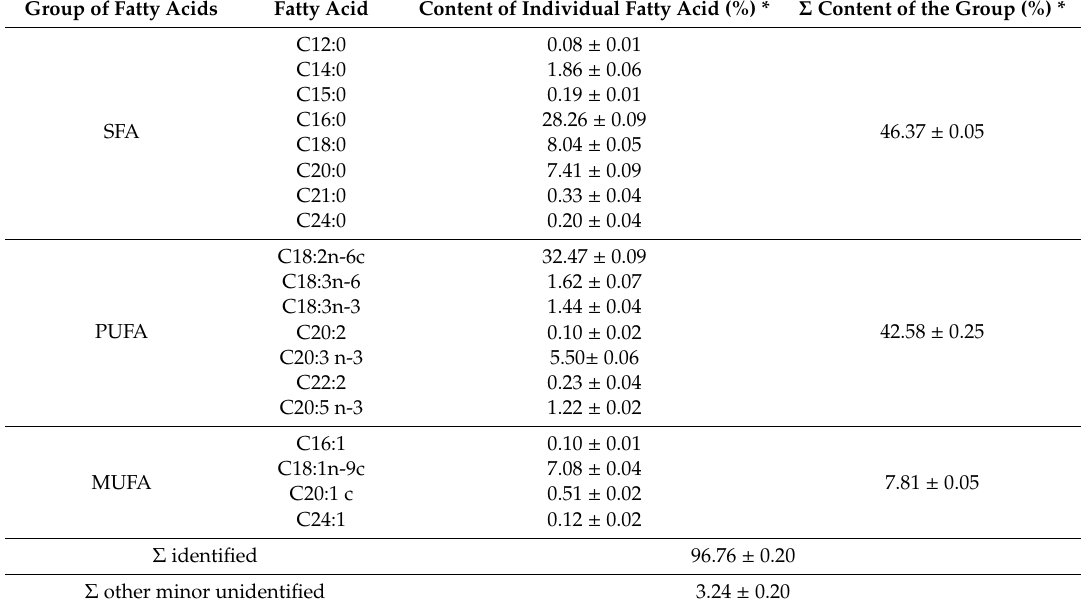
Table 3. Fatty acids composition (%) of co ff ee silverskin fat samples (SFA—saturated fatty acids, MUFA—monounsaturated fatty acids, PUFA—polyunsaturated fatty acids). Group of Fatty Acids